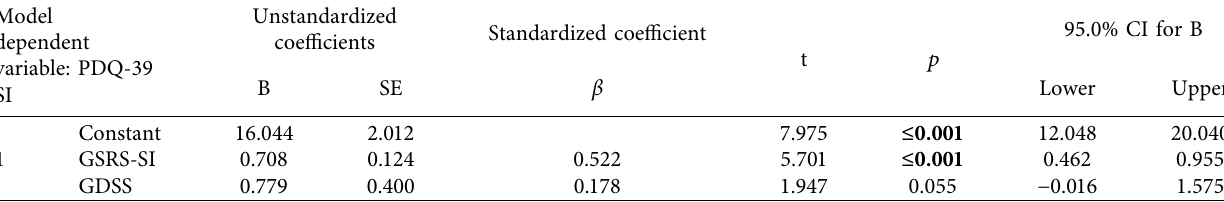
Table 2: Generalized linear model coefficients for PDQ-39 SI on both gastrointestinal assessments (GSRS and GDSS).